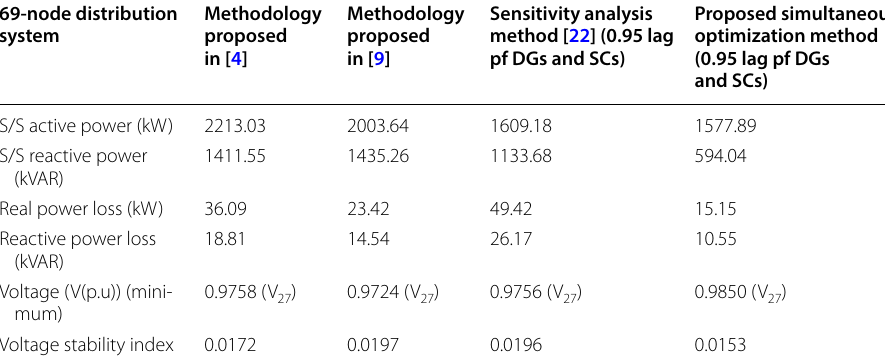
Table 8 Performance comparison for 69-node distribution system